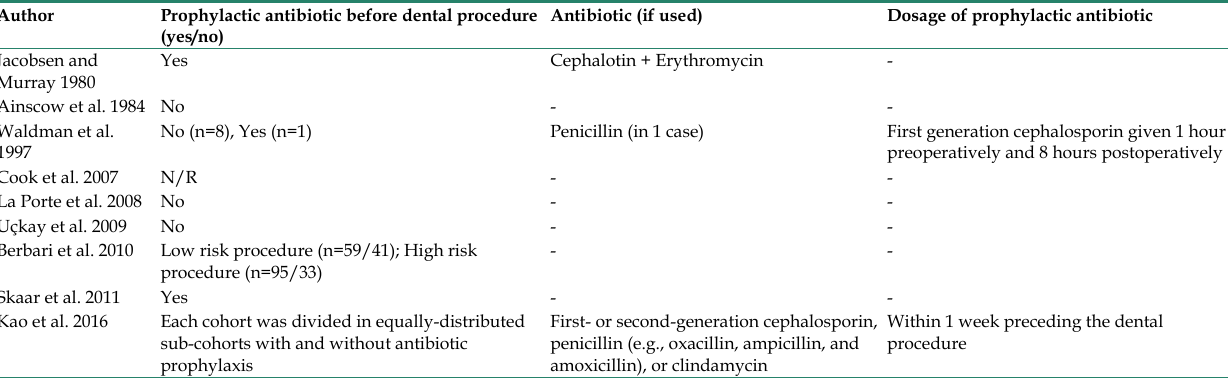
Table 5. Indication of antibiotic prophylaxis and dosage